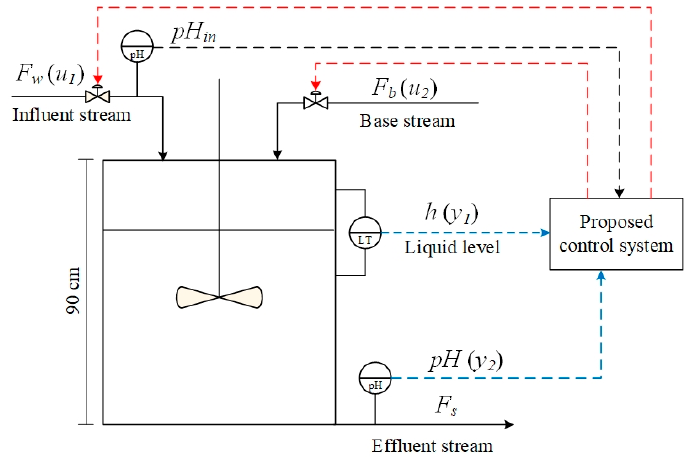
Figure 5. Schematic diagram of a pH process.